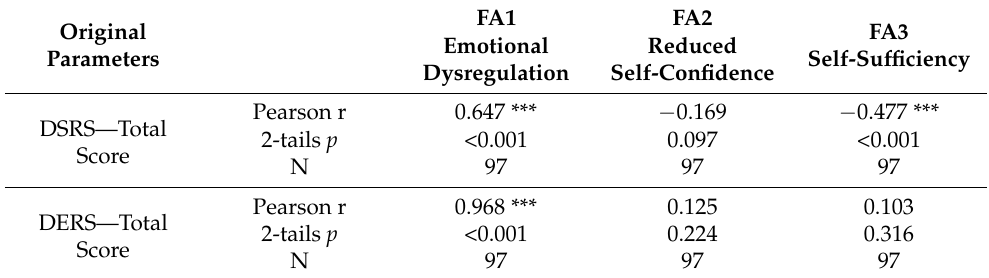
Table 8. Correlations between original scales’ Total Scores and Extracted